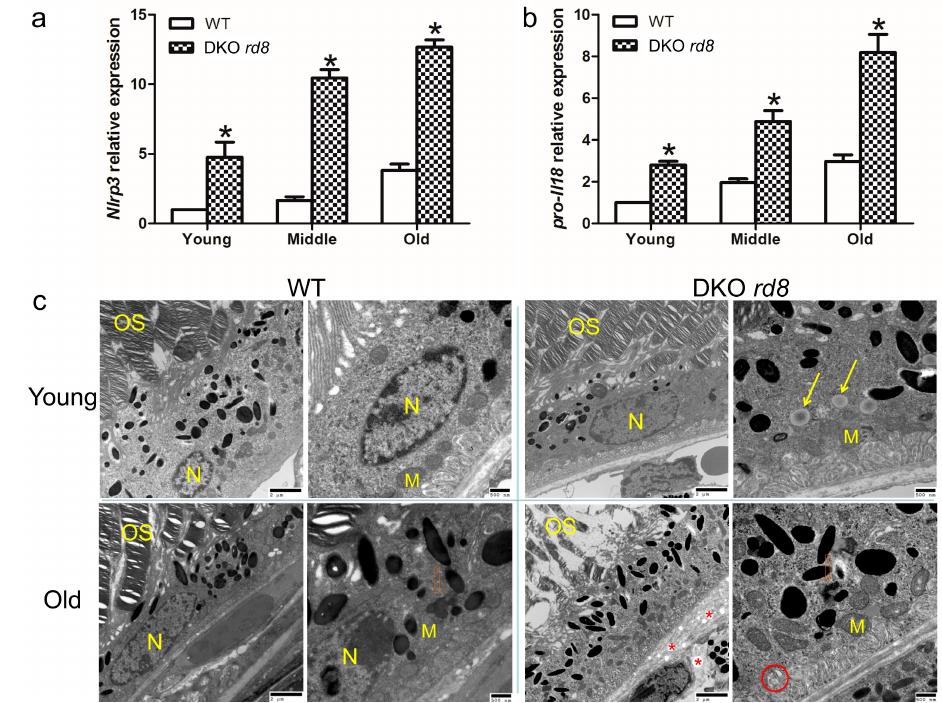
Figure 4. Upregulation of NLRP3 inflammasome in an AMD model of Ccl2/Cx3cr1 double knockout on C57BL/6N (DKO rd8 ) mouse retina. ( a ) qRT-PCR analysis of Nlrp3 mRNA in WT (C57BL/6N) and DKO rd8 mouse retina of different age groups as young (1 month), middle (4–5 months) and old (11–12 months) ( n = 4). Significantly higher mRNA levels are measured in mutant mice and are age-dependent; ( b ) qRT-PCR analysis of pro- Il18 mRNA in DKO rd8 mouse retina of different age groups ( n = 4). Significantly higher mRNA levels are measured in mutant mice and are age-dependent; ( c ) TEM images of the retinas of young and old WT and DKO rd8 . The young RPE cells of WT mouse show normal nuclei (N) and healthy mitochondria (M) in the cytoplasmic base. The photoreceptor outer segments (OS) are well aligned. There is a lysosome with lipid bodies ( orange open arrow) in the RPE of old WT. In contrast, there are more lipid droplets ( yellow arrows) in a young DKO rd8 RPE. Lysosomes with lipid bodies (open arrow) are identified in an old DKO rd8 RPE. Additionally, DKO rd8 RPE showed autophagosome ( red circle), as well as a higher number of cytoplasmic vacuoles (asterisks). The photoreceptor OS are poorly aligned and undergo degeneration. Data are presented as mean ± SEM. * p < 0.05. Scale bars are 2 µm and 500 nm.